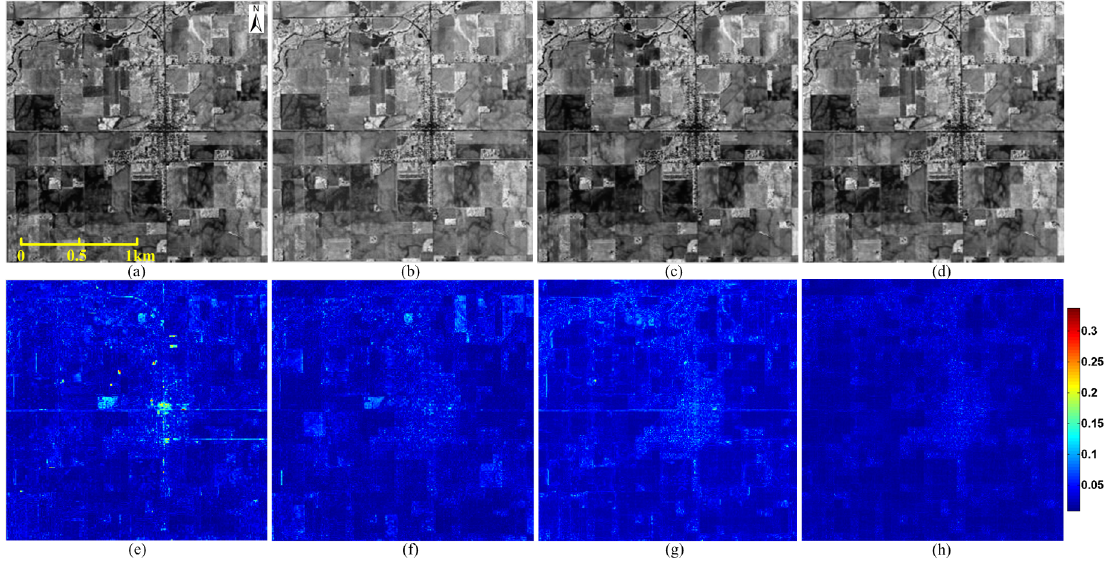
Figure 6. Reconstructed images (band 70) and root mean square error (RMSE) maps of different fusion results by a factor of four. The testing image is cropped from Indian pines of AVIRIS data with size 256 × 256. ( a ) result of SSR [12]; ( b ) result of BayesSR [13]; ( c ) result of CNMF [6]; ( d ) result of Two-CNN-Fu; ( e ) RMSE map of SSR [12]; ( f ) RMSE map of BayesSR [13]; ( g ) RMSE map of CNMF [6]; ( h ) RMSE map of Two-CNN-Fu.